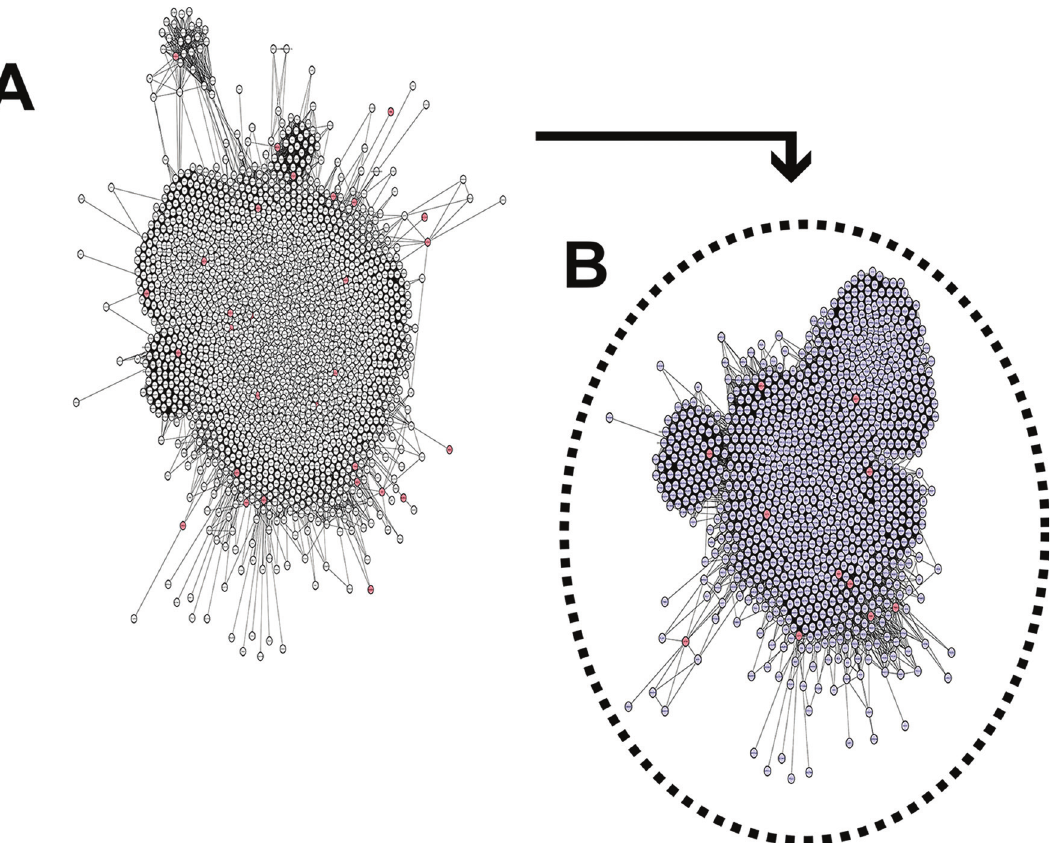
Figure 3 - The PPI network. The list of 44 genes was obtained from the human assembly of February 2009 (GRCh37/hg19). Interaction data from STRING were used to construct networks using Cytoscape software. (A) The primary network is composed of 2284 nodes and 83,340 edges. Red nodes are target proteins (SLC6A3, SRD5A1, CCT5, ADCY2, TAS2R1, MED10, MTRR, SLC12A7, CEP72, NDUFS6, MARCH6, LPCAT1, NKD2, CTNND2, TERT, CLPTM1L, MRPL18, MRPL36, UBE2QL1, PAPD7, and TPPP). (B) Secondary network composed of 1062 nodes and 41,309 edges. Rednodesarecandidateproteins(CCT5,TPPP,MED10,ADCY2,MTRR,CEP72,NDUFS6,MRPL36,CTNND2,TERT,andSLC6A3)andimmediate neighbors from